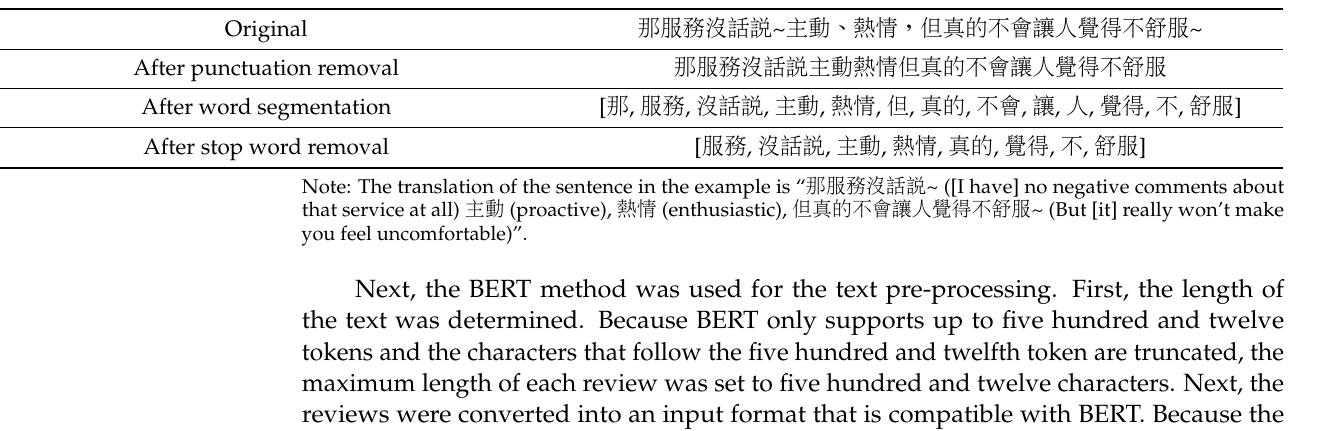
Table 3. Outputs of text pre-processing using the conventional